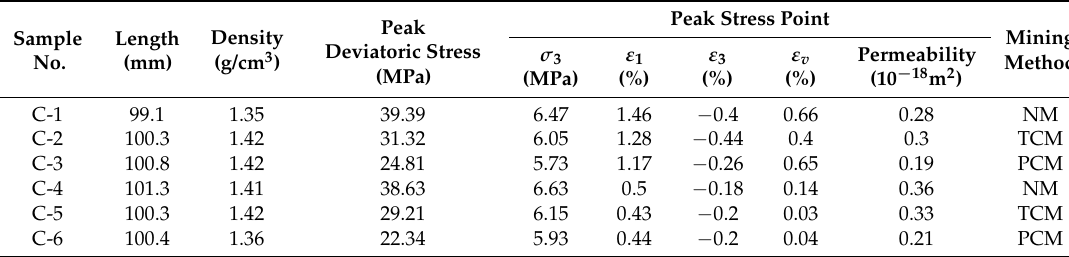
Table 1. Experimental parameters of coal